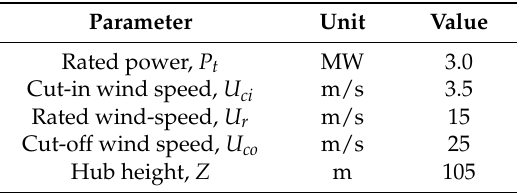
Table 3. Fact and figures of wind turbine V90-3.0 MW.